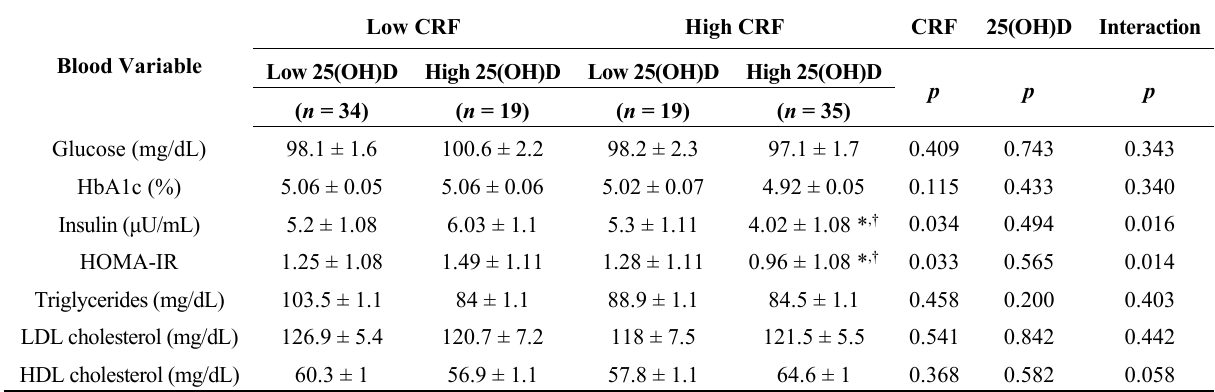
Table 3. Joint association of 25(OH)D and CRF with parameters related to insulin resistance. Blood